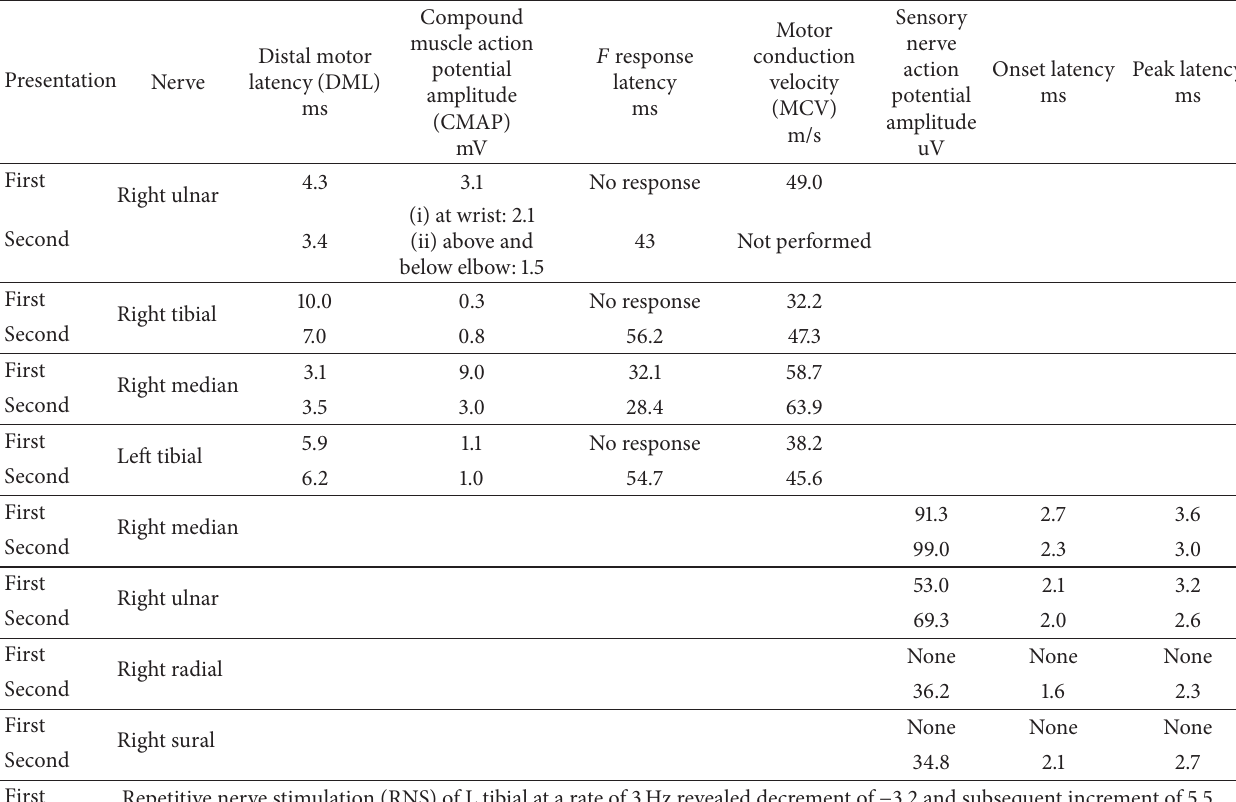
Table 2: Nerve conduction/electromyography study on 1st and 2nd presentation of GBS.